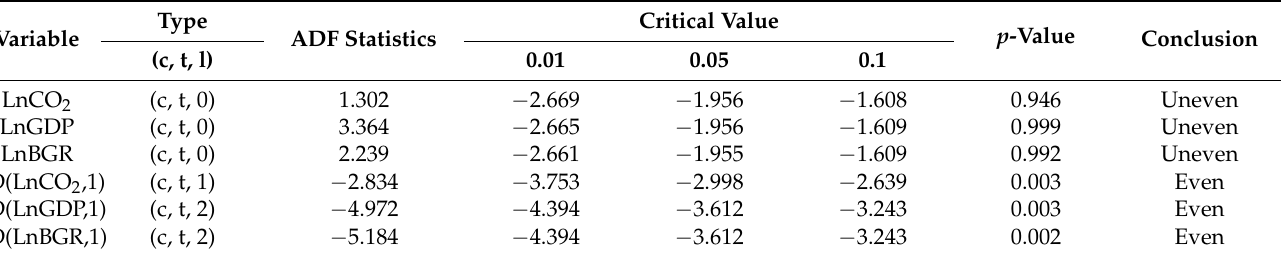
Table 6. ADF test results.